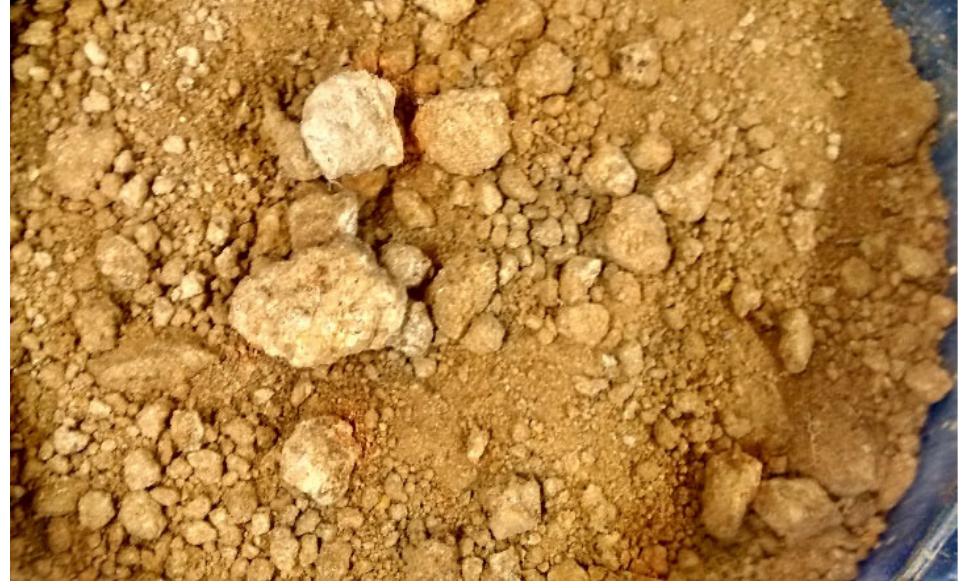
Figure 3. Selected fine granular excavation soil (own source).